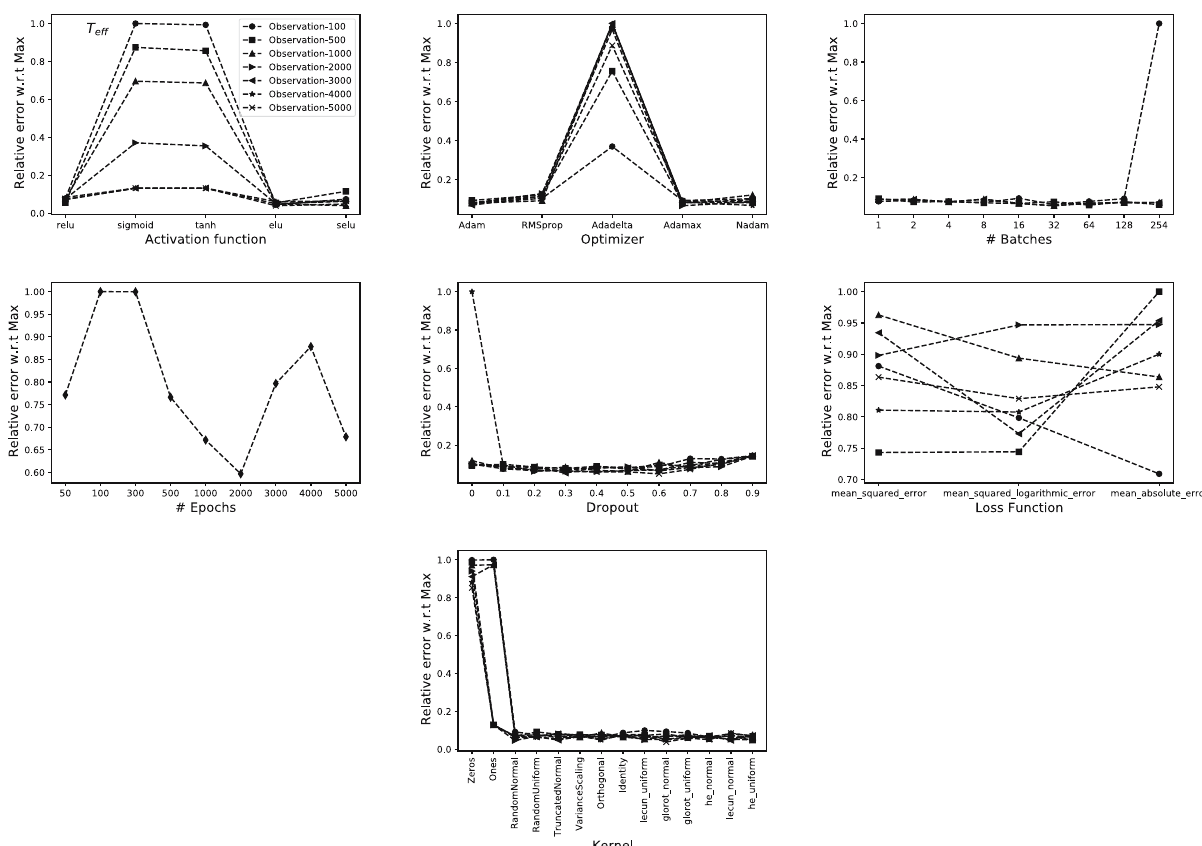
Figure 5: E ff ect of varying the CNN parameters on the accuracy of T eff for di ff erent epoch numbers. The results are displayed by dividing the observation standard deviation by their maximum value in each